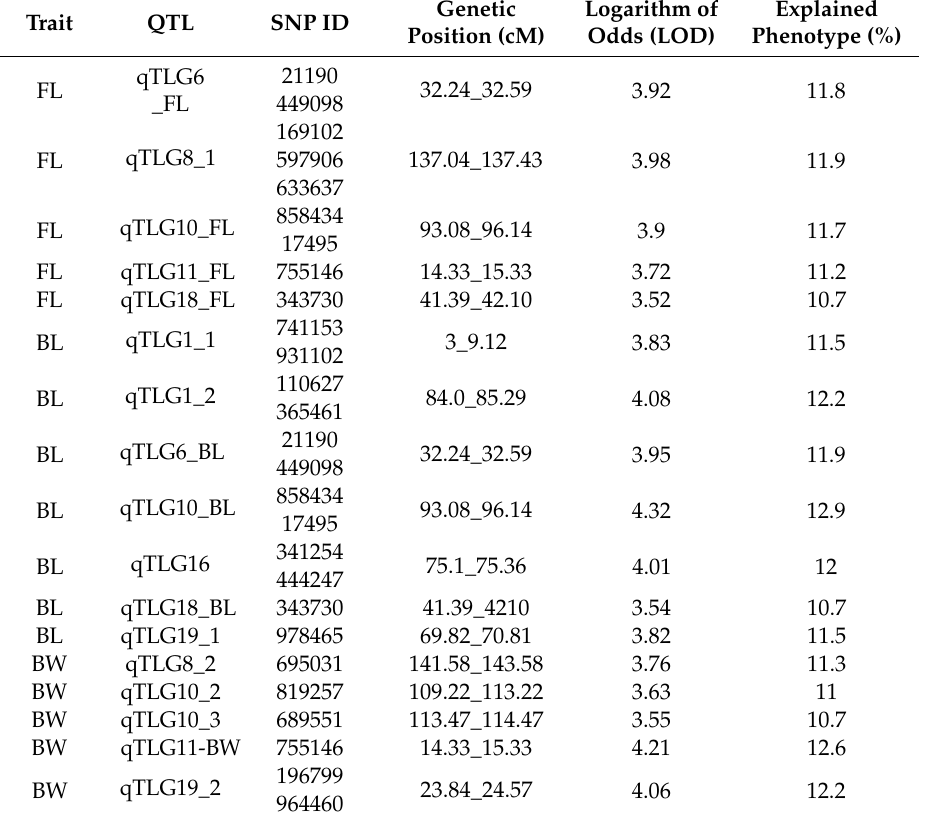
Table 2. On growth-related QTLs in the red-spotted grouper. SNP: single nucleotide polymorphism; FL: full length; BL: body length; BW: body